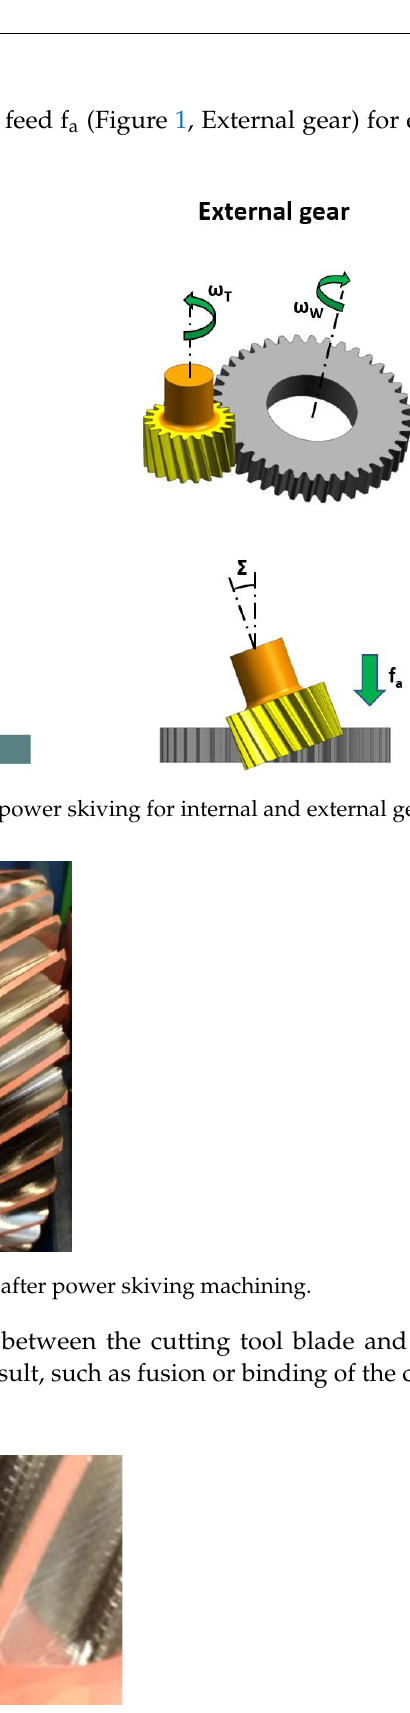
Figure 3. Bound chip on the tooth involute surface, after power skiving machining.